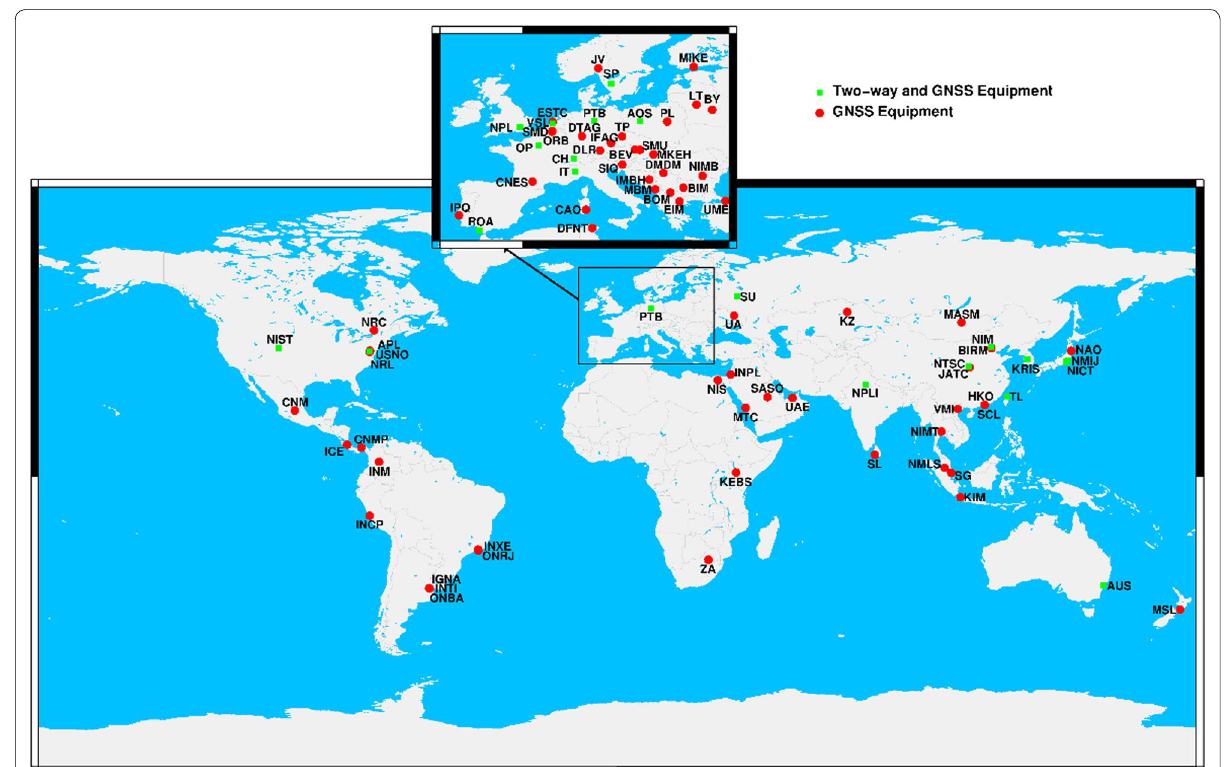
Fig. 3 Geographical distribution of the laboratories contributing to UTC (2018)